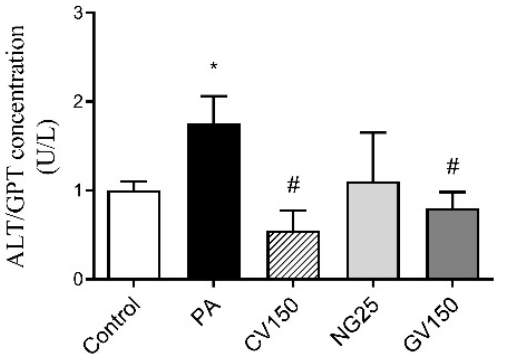
Figure 4. Alanine aminotransferase (ALT/GPT) level in cell culture medium of AML12 hepatocytes exposed or not to 0.3 mM of palmitic acid (PA) with or without Chlorella vulgaris (CV) at 150 µg/mL, Nannochloropsis gaditana (NG) at 25 µg/mL and Gracilaria vermiculophylla (GV) at 150 µg/mL for 18 h. Data are means ± SEM (standard error of the mean). * p < 0.05 vs. control cells, # p < 0.05 vs. PA cells.